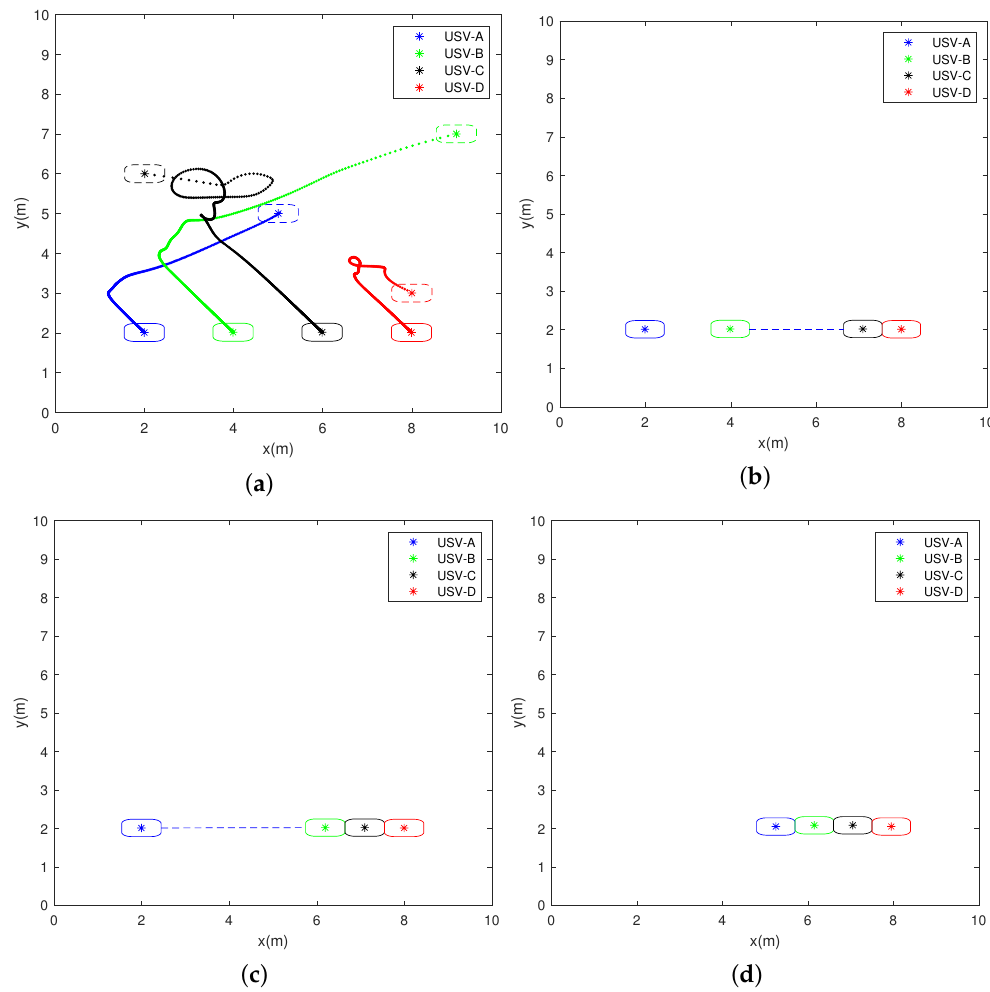
Figure 16. Diagram of the docking process of USVs in a line formation: ( a ) the process of formation; ( b ) USV-C docking completed; ( c ) USV-B docking completed; ( d ) USV-A docking